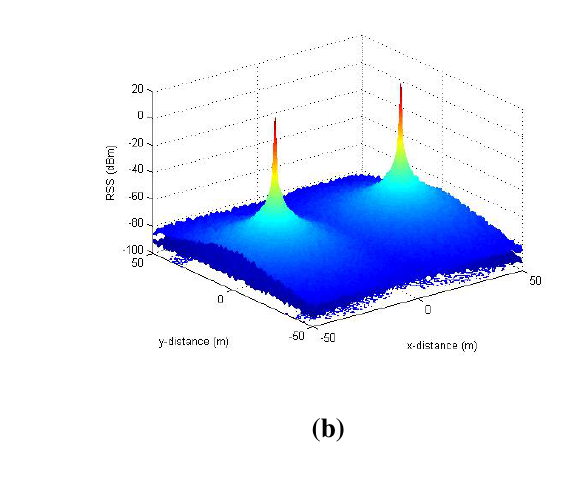
Figure 7. Simulation of the radio environment in 2D. The server node is placed at (30,0), and the client node is placed at ( − 30,0). ( a ) Simulations without Gaussian noise; ( b ) Simulations with Gaussian noise N (0 , 2)